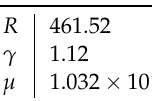
Table 1. Ideal gas parameters used for the steam